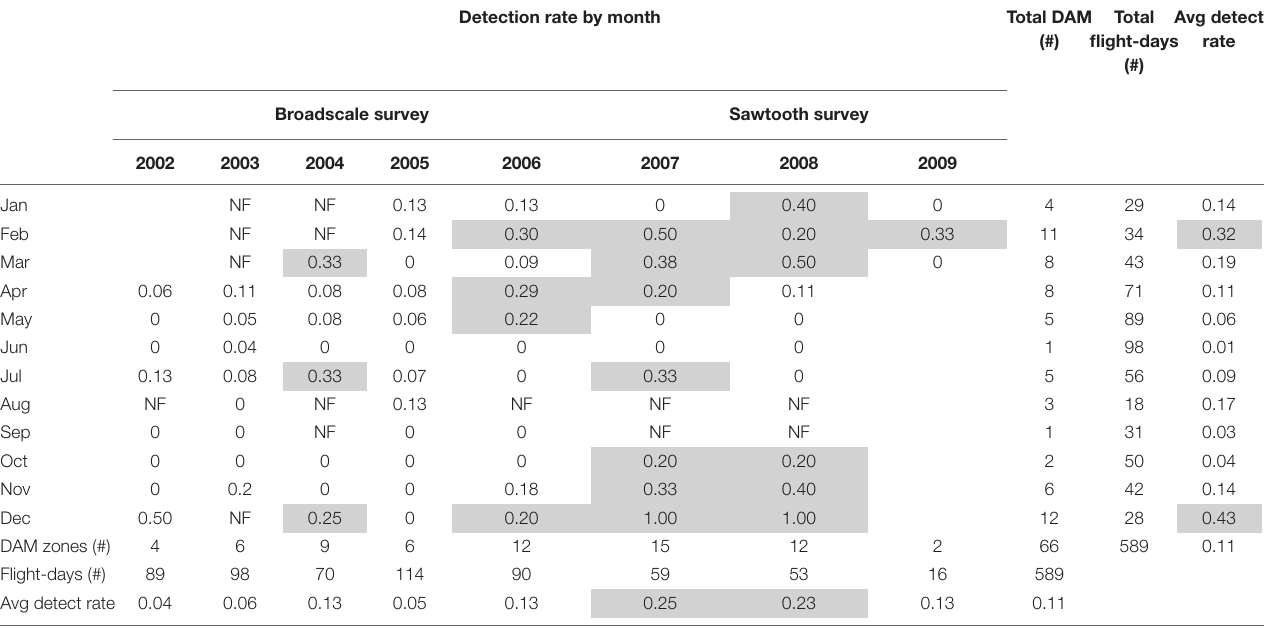
TABLE 4 | The Dynamic Area Management (DAM) detection rate (=No. DAMs/No. flight-days) for broadscale and sawtooth survey methods by year and month. The total number of DAM zones triggered, North Atlantic Right Whale Sighting Survey flight days a and average detection rate (avg detect rate) across years and months. Shaded areas show detection rates of 20% or greater and NF = no